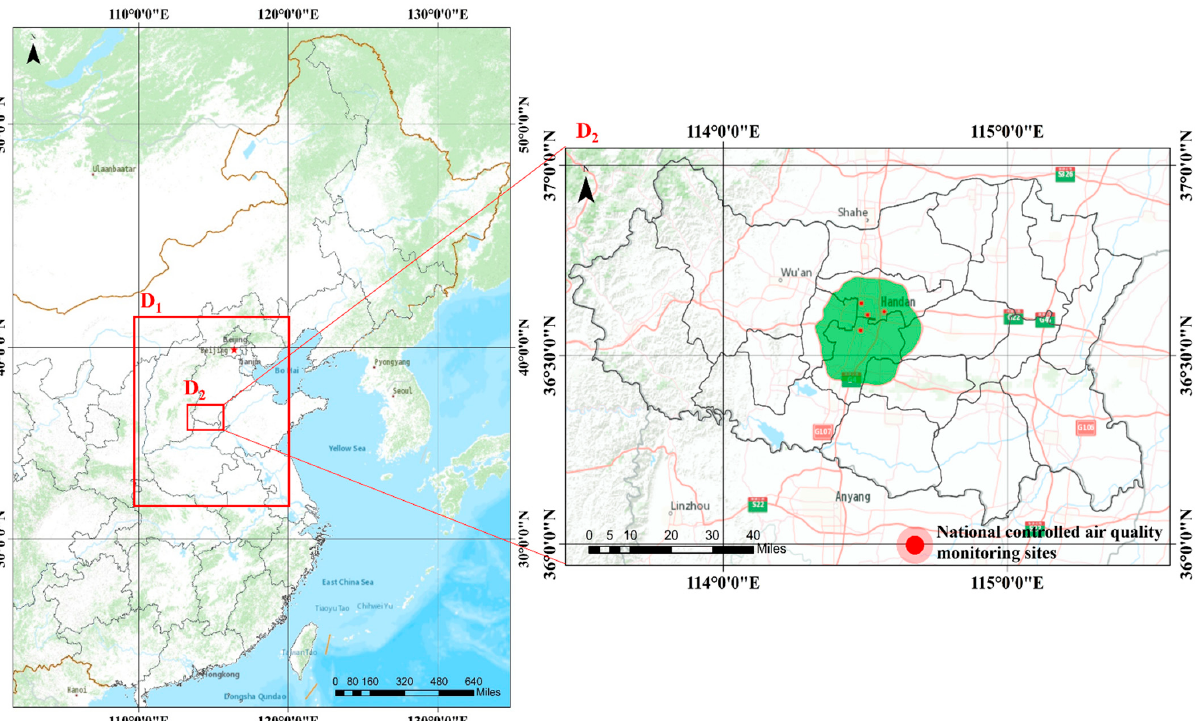
Figure 1. Two nested simulation domains of Community Multiscale Air Quality (CMAQ) model and distribution of national controlled air quality monitoring sites in Handan. Black contour lines show the political boundaries of Handan (D 2 ), green areas are downtown Handan (D 2 ).